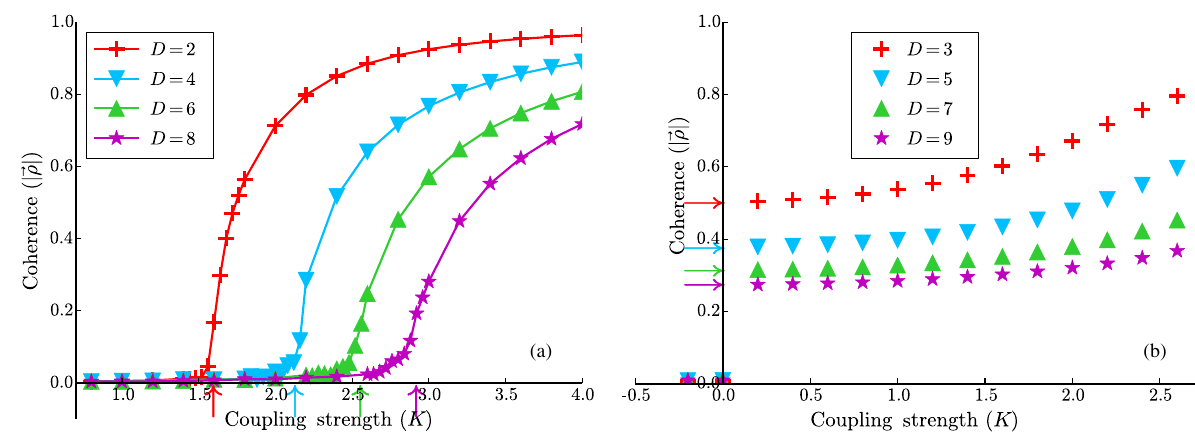
FIG. 4. (a) Phase transitions for the generalized Kuramoto model for D ¼ 2 (red plus signs), 4 (blue inverted triangles), 6 (green triangles), and 8 (magenta stars) dimensions, numerical observations for N ¼ 10 5 . (b) Phase transitions for the Kuramoto model generalized to D ¼ 3 (red plus signs), 5 (blue inverted triangles), 7 (green triangles), and 9 (magenta stars) dimensions, numerical observations for N ¼ 10 4 . Δ ¼ 1 in each. The theoretical predictions from Eqs. (42) and (44) for the critical coupling strength for even dimensions has been shown in correspondingly colored arrows on the x axis in (a). For a discussion on the slight mismatch between the theory and the numerical results, see Sec. III C. We expect this mismatch to decrease with increasing N . The theoretical estimates from Eq. (13) for the magnitude of the discontinuity, i.e., j ρ j at K → 0 þ , are shown in correspondingly colored arrows on the y axis in (b). Note the close match between the theoretical result for the discontinuity and the numerical observation for j ρ j at K ¼ 0 . 2